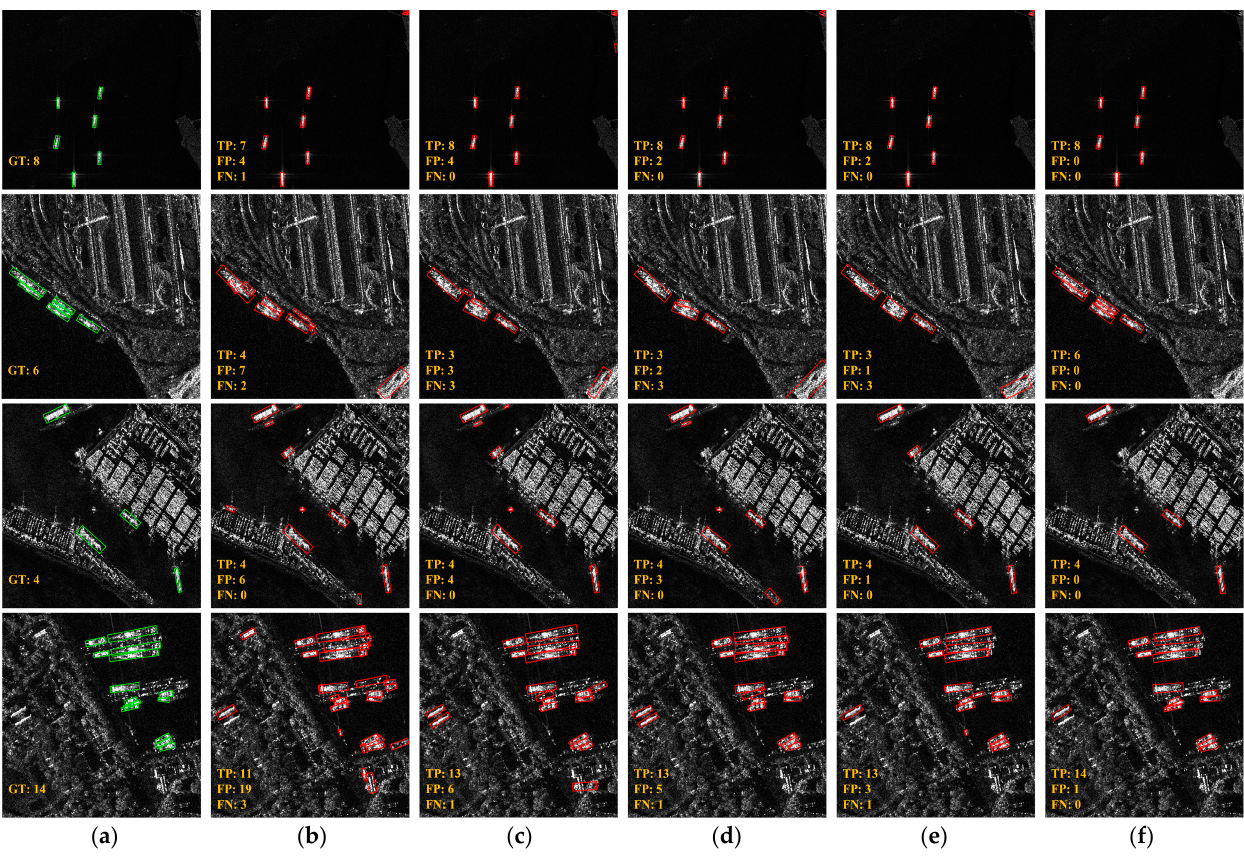
Figure 24. Detection results of different methods on RSSD. ( a ) Ground truth (GT); ( b ) RetinaNet-R; ( c ) CS 2 A-Net; ( d ) ReDet; ( e ) GWD; ( f ) TDIoU + AW-FPN (ours). Green and red boxes represent real ship targets and detection results, respectively. Table 11. Comparison with state-of-the-art methods on SSDD. Here, V-16 and C-53 denote VGG16 [75] and CSPDarknet53 [76]. The method with * indicates that its results are from the corresponding paper. Here, (<800) indicates that the long side of images is less than 800